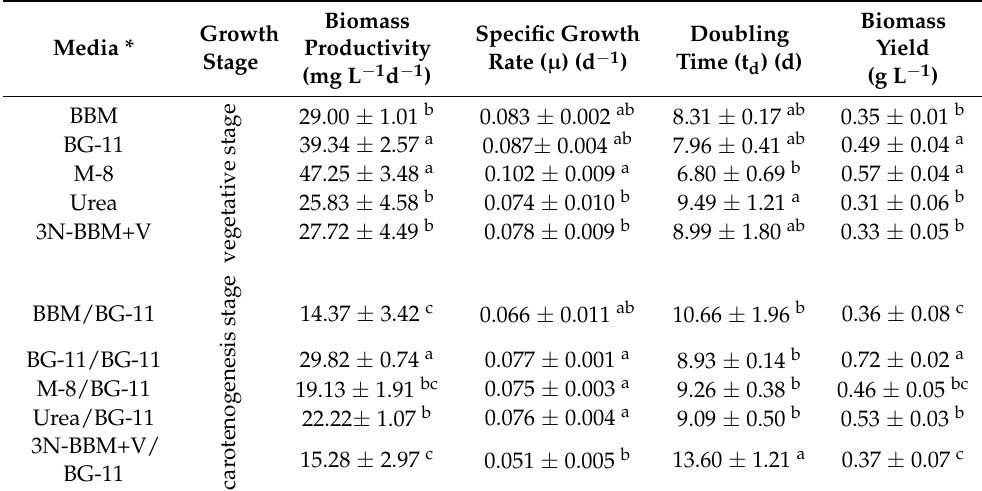
Table 1. Kinetics of Coelastrella sp. growth in different culture media.